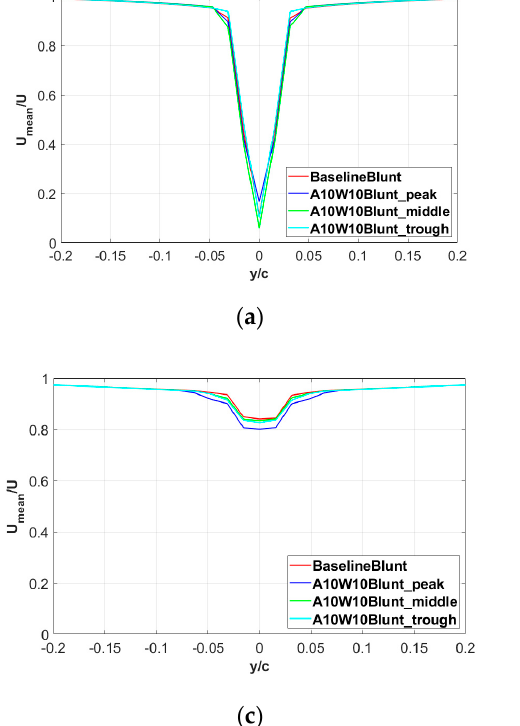
1.1 c . The maximum turbulence intensity at middle position is reduced from 21% to 15%.